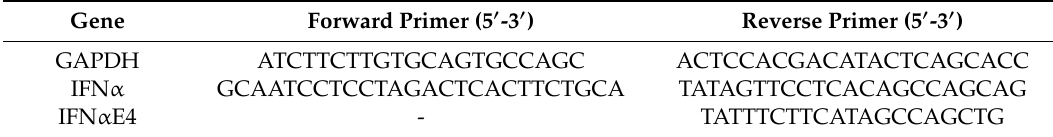
Table 2. Sybr green primers used for qPCR